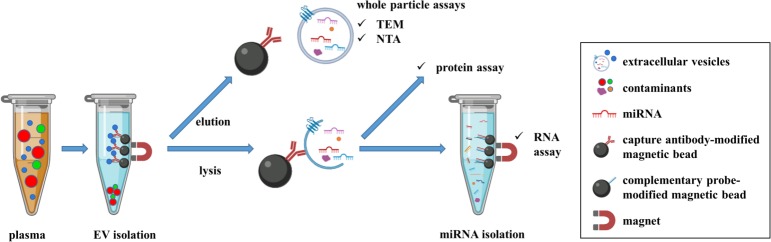
The schematic diagram of the experimental procedure.EVs in human plasma samples were first isolated using anti-CD63 antibody-coated magnetic beads. Captured EVs were then eluted for whole particle assays, such as transmission electron microscopy and nanoparticle tracking analysis. In addition, captured EVs were lysed for studying their molecular contents, including proteins and RNAs. EV-miRNAs were extracted using oligonucleotide-conjugated magnetic beads and subjected to subsequent analysis.